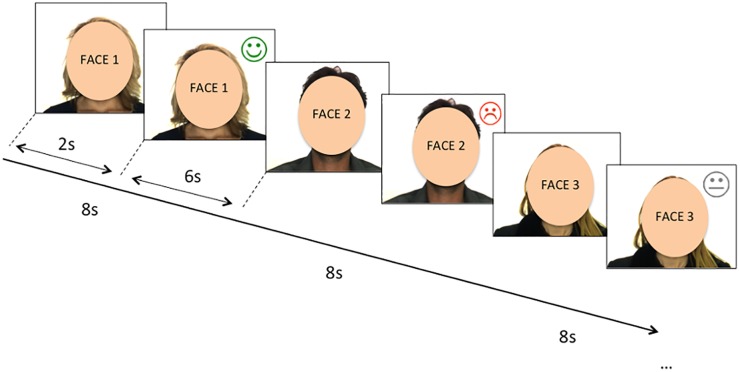
Diagram of the Social Judgment Task used in the fMRI session.Participants received social feedback based on the willingness to be met by other participants. Each facial stimulus (represented in by ovals instead of the originally presented faces) was presented for a total of 8 second-blocks, with an overlapping feedback symbol during the last 6 seconds. Acceptance, rejection or no-feedback (control condition) was indicated by a happy, sad, or neutral draw of a face. Originally presented images were contained in a preexisting face database: Martinez AM, Benavente R. The AR Face Database CVC Tech. Report #24 [Internet]. 1998. Available: http://www2.ece.ohio-state.edu/~aleix/ARdatabase.html.